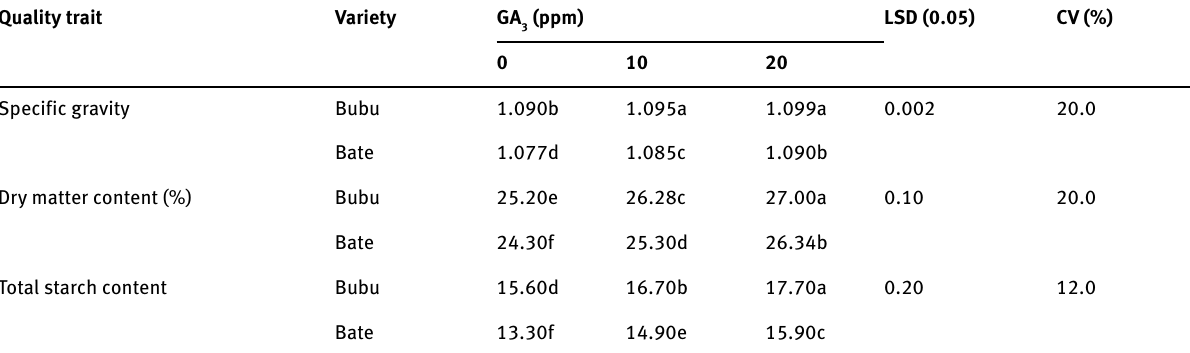
Means in rows and columns in each parameter with similar letter(s) are not significantly different. LSD (0.05)-List significant difference